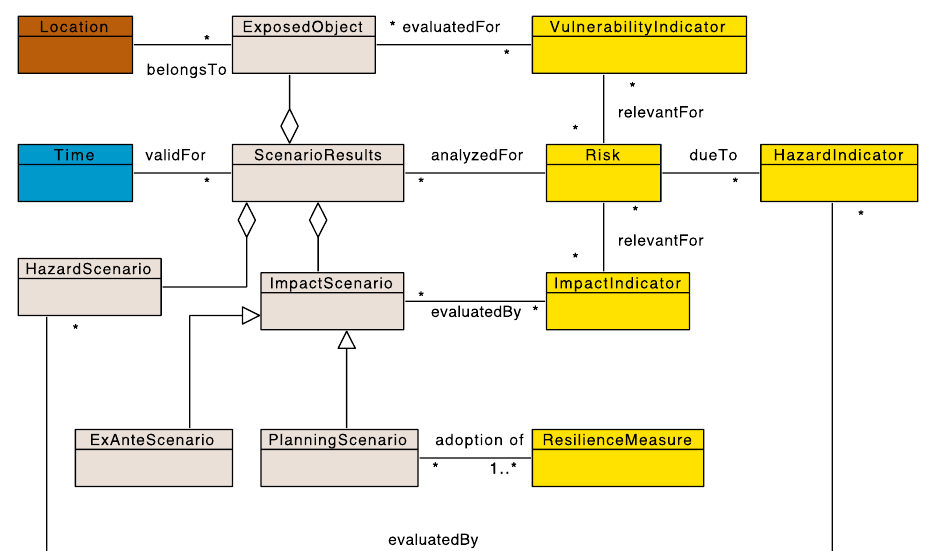
Figure 4. Data model represented as a UML class diagram. The yellow color highlights the risk/resilience variables and definitions that are used to evaluate the scenarios (how). The Scenario-Results entity is a container for the Hazard-Scenario values, Exposure/Vulnerability values and the computed Impacts (what). Location refers to the geographic place of the objects exposed at risk (where) and Time to the time periods of reference for the scenarios (when), * stands for